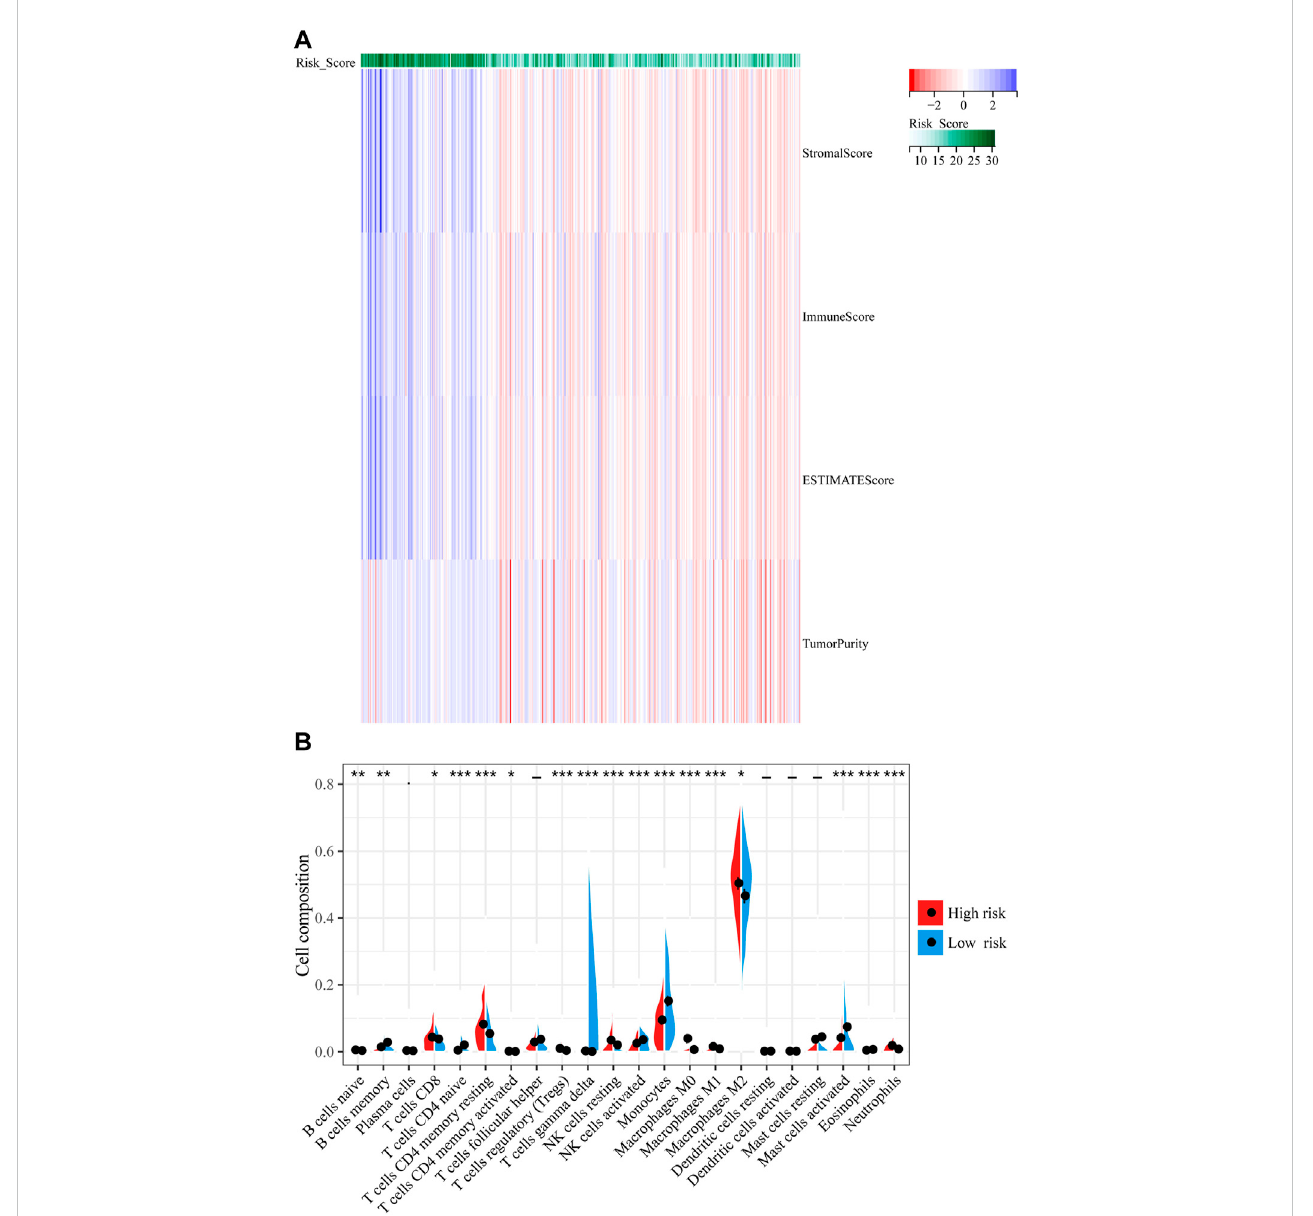
FIGURE 6 Correlation between IFN- γ -associated gene scoring model and tumor microenvironment. (A) The ESTIMATE algorithm to explore the relationship between the risk models and immune cell in fi ltration. (B) The percentages of 22 immune cells were assessed using CIBERSORT. ** p < 0.01, **** p < 0